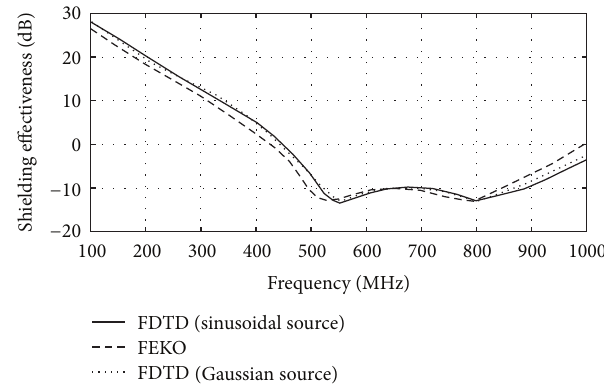
F 3: Comparison among the values of the SE obtained using threedifferentmethodsforabox-shapedenclosureofdimensions30 with rectangular aperture of dimensions 20 12 30cm -polarized plane wave. 3 × × 𝐸𝐸 𝑦𝑦